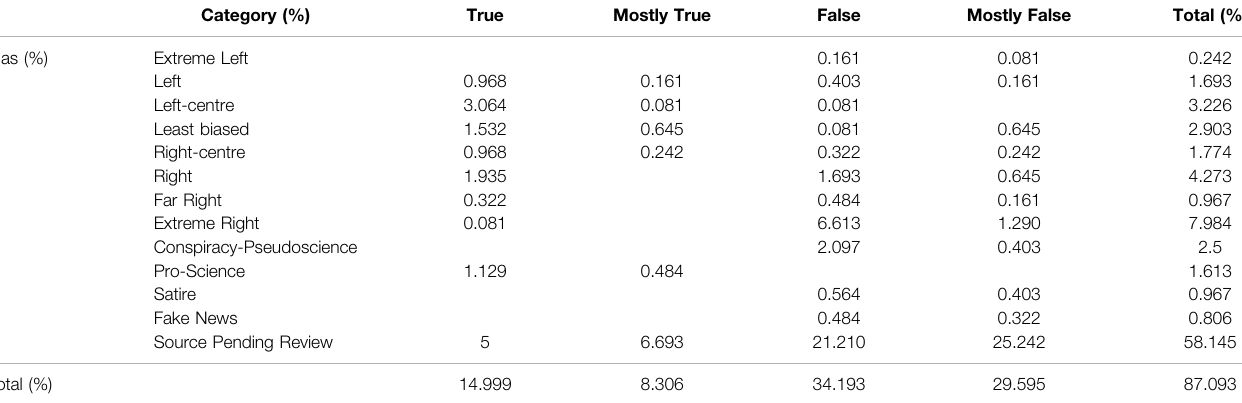
TABLE 4 | Relative frequency of news sources within right-left political spectrum by reliable ( “ True ” / “ Mostly true ” ) and unreliable ( “ False ” / “ Mostly false ” ) categories. Some news sources are listed by Media Bias/Fact Check (MBFC) as either Pro-Science, Conspiracy-Pseudoscience, Satire, or Fake News. The percentage denotes the proportionofthecorrespondingcategories ’ newssourcesonthatbias.Thereviewof58%ofnewssourceshasnotbeencompletedbyMBFCatthetimeoftheanalysisand c. 13% of news sources (mostly having .it, .net, .co.uk, .fr, .co, .mx, or .news as top-level domain) has not matched any result in MBFC database.